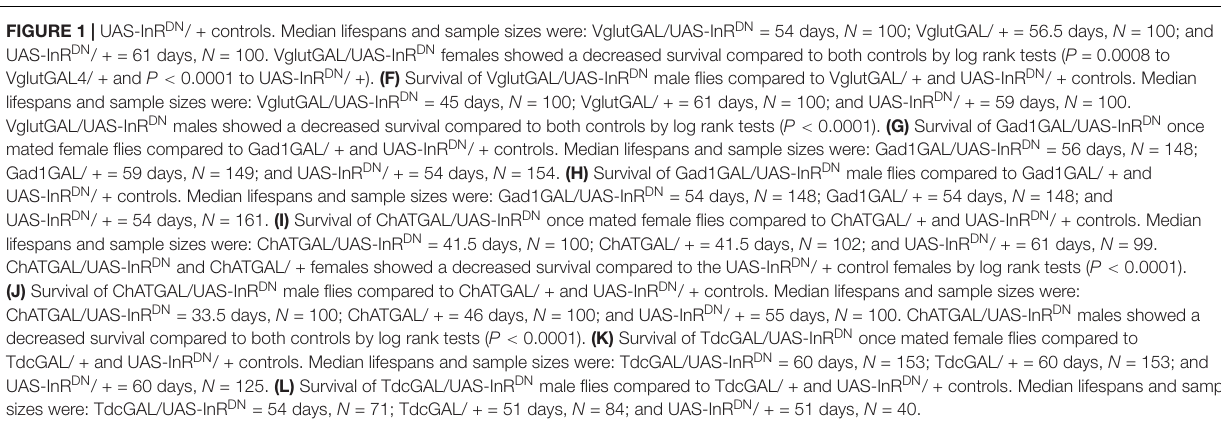
FIGURE 1 | UAS-InR DN / + controls. Median lifespans and sample sizes were: VglutGAL/UAS-InR DN = 54 days, N = 100; VglutGAL/ + = 56.5 days, N = 100; and UAS-InR DN / + = 61 days, N = 100. VglutGAL/UAS-InR DN females showed a decreased survival compared to both controls by log rank tests ( P = 0.0008 to VglutGAL4/ + and P < 0.0001 to UAS-InR DN / +). (F) Survival of VglutGAL/UAS-InR DN male flies compared to VglutGAL/ + and UAS-InR DN / + controls. Median lifespans and sample sizes were: VglutGAL/UAS-InR DN = 45 days, N = 100; VglutGAL/ + = 61 days, N = 100; and UAS-InR DN / + = 59 days, N = 100. VglutGAL/UAS-InR DN males showed a decreased survival compared to both controls by log rank tests ( P < 0.0001). (G) Survival of Gad1GAL/UAS-InR DN once mated female flies compared to Gad1GAL/ + and UAS-InR DN / + controls. Median lifespans and sample sizes were: Gad1GAL/UAS-InR DN = 56 days, N = 148; Gad1GAL/ + = 59 days, N = 149; and UAS-InR DN / + = 54 days, N = 154. (H) Survival of Gad1GAL/UAS-InR DN male flies compared to Gad1GAL/ + and UAS-InR DN / + controls. Median lifespans and sample sizes were: Gad1GAL/UAS-InR DN = 54 days, N = 148; Gad1GAL/ + = 54 days, N = 148; and UAS-InR DN / + = 54 days, N = 161. (I) Survival of ChATGAL/UAS-InR DN once mated female flies compared to ChATGAL/ + and UAS-InR DN / + controls. Median lifespans and sample sizes were: ChATGAL/UAS-InR DN = 41.5 days, N = 100; ChATGAL/ + = 41.5 days, N = 102; and UAS-InR DN / + = 61 days, N = 99. ChATGAL/UAS-InR DN and ChATGAL/ + females showed a decreased survival compared to the UAS-InR DN / + control females by log rank tests ( P < 0.0001). (J) Survival of ChATGAL/UAS-InR DN male flies compared to ChATGAL/ + and UAS-InR DN / + controls. Median lifespans and sample sizes were: ChATGAL/UAS-InR DN = 33.5 days, N = 100; ChATGAL/ + = 46 days, N = 100; and UAS-InR DN / + = 55 days, N = 100. ChATGAL/UAS-InR DN males showed a decreased survival compared to both controls by log rank tests ( P < 0.0001). (K) Survival of TdcGAL/UAS-InR DN once mated female flies compared to TdcGAL/ + and UAS-InR DN / + controls. Median lifespans and sample sizes were: TdcGAL/UAS-InR DN = 60 days, N = 153; TdcGAL/ + = 60 days, N = 153; and UAS-InR DN / + = 60 days, N = 125. (L) Survival of TdcGAL/UAS-InR DN male flies compared to TdcGAL/ + and UAS-InR DN / + controls. Median lifespans and sample sizes were: TdcGAL/UAS-InR DN = 54 days, N = 71; TdcGAL/ + = 51 days, N = 84; and UAS-InR DN / + = 51 days, N =